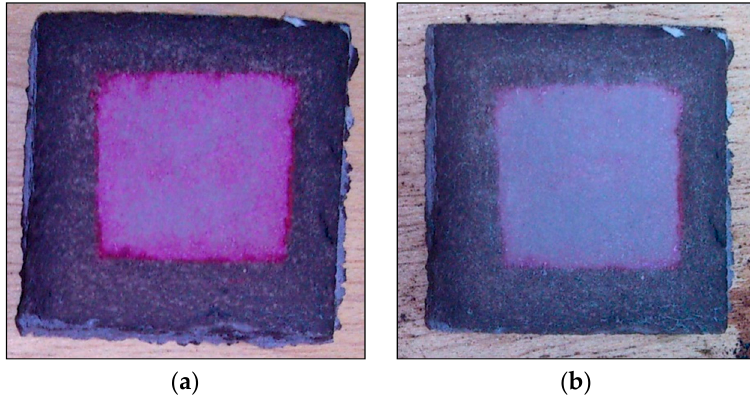
Figure 8. The RhB degradation test. Mortar specimen before ( a , b ) after 26 h of light irradiation. The red stain was reduced after irradiation. The mortar without waste in its composition remained unchanged (image not shown). The R 26 index value is a quantitative evaluation of RhB dye photodegradation. In samples M5-HSL600 and M10-HSL600, the R 26 values were 21.7% and 56.55%, respectively. Therefore, the results obtained for M10-HSL600, with dye degradation in the mortar higher than 50%, are indicative of a positive self-cleaning performance.